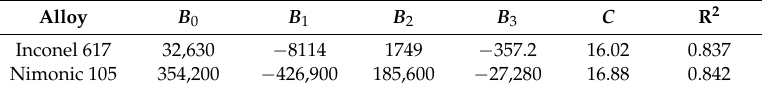
Table 9. MATLAB calculations of the LMP coefficients and goodness of